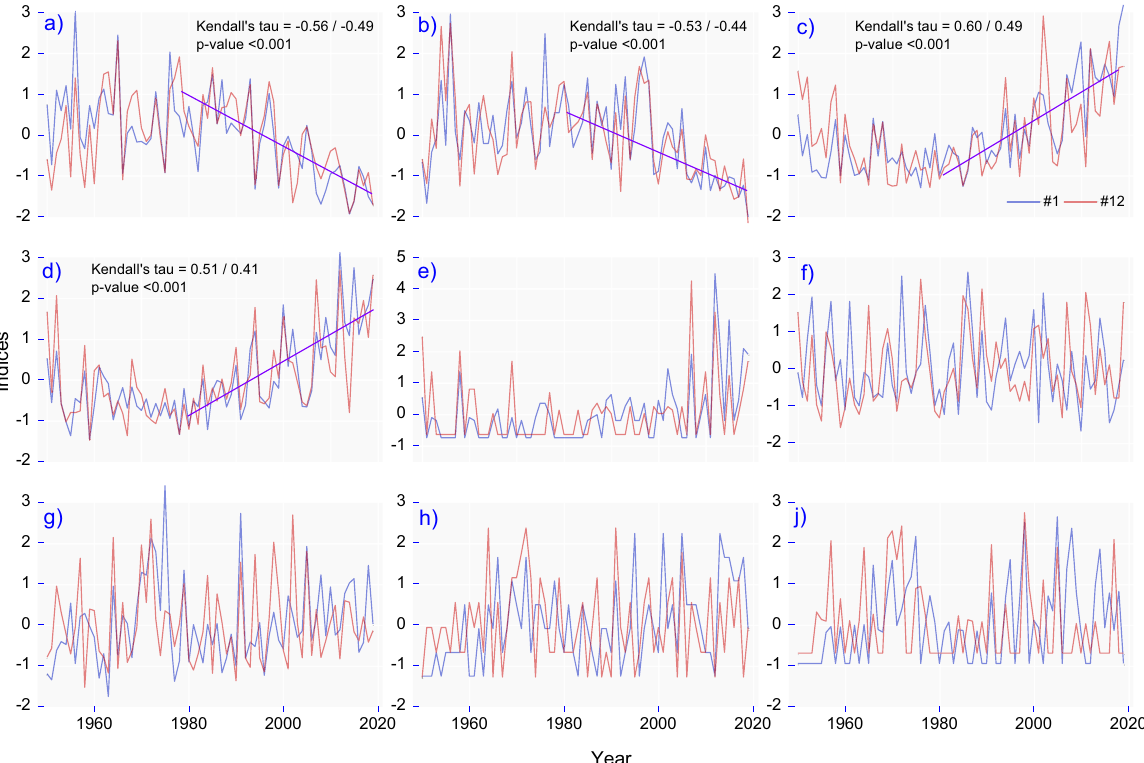
Fig. 2 Normalized values for extreme climate indices in extreme sites Cornetu Lake (#1 — blue line) and Danube River — upstream the Olt River (#12 — red line). a TN10p — the annual percentage of days when TN < 10th percentile; b TX10p — the annual percentage of days when TX < 10th percentile; c TN90p — the annual percentage of days when TN > 90th percentile; d TX90p — the annual percentage of days when TN > 90th percentile; e WSDI — the annual number of days contributing to events where six or more consecutive days experience TX > 90th percentile; f CDD — the maximum annual number of consecutive dry days (when precipitation < 1.0 mm); g RRX5day — maximum 5-day precipitation total; h RR20mm — annual number of days when precipitation ≥ 20 mm, and j RR90p — the annual percentage of days when TX > 90th percentile. The climate data were extracted from European Climate Assessment and Dataset (ECA&D) database (https://www.ecad.eu/